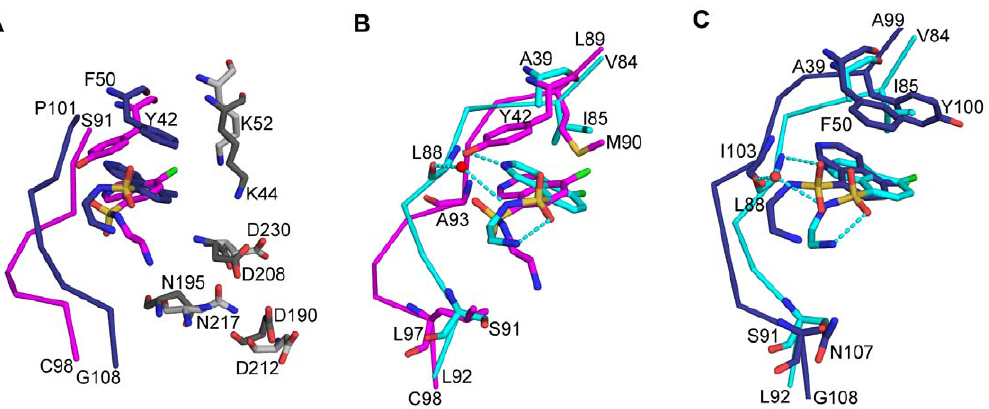
Figure 3. Comparisons of CKI-7 binding to APH(3 9 )-IIIa, APH(9)-Ia and CK1. The structures are superposed using the conserved residues among the enzymes. (A) Superposition of CKI-7-bound APH(3 9 )-IIIa and APH(9)-Ia. The conserved active site residues between APH(3 9 )-IIIa and APH(9)-Ia are colored dark grey and light grey respectively. The APH(3 9 )-IIIa-bound CKI-7 is shown as magenta sticks and the APH(9)-Ia-bound CKI-7 is shown as dark blue sticks. The rotation between the planes of the isoquinoline rings of CKI-7 bound to APH(3 9 )-IIIa and APH(9)-Ia is approximately 40 u . (B) Superposition of CKI-7-bound APH(3 9 )-IIIa and CK1. The same degree of rotation as that observed between the isoquinolines of the APH(3 9 )- IIIa- and APH(9)-Ia-bound CKI-7 is observed here. (C) Superposition of CKI-7-bound APH(9)-Ia and CK1. The CKI-7 isoquinoline rings are coplanar. In panels (B) and (C), APH(3 9 )-IIIa and APH(9)-Ia are colored as in panel A, and CK1 is colored in cyan. The residues that interact with CKI-7 and those with dissimilar properties from ePK nucleotide-binding site are shown in sticks. Hydrogen bond interactions between CKI-7 and CK1 are illustrated as dash lines. Water molecule is represented by a red sphere.